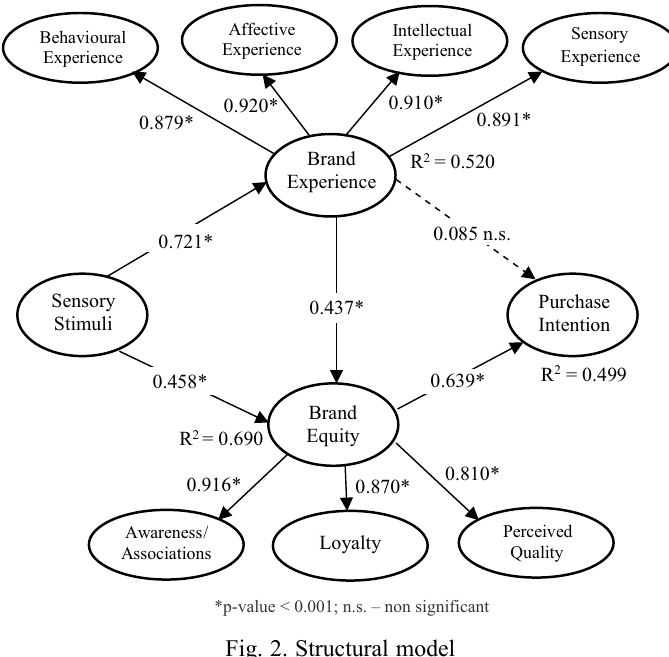
Fig. 2. Structural